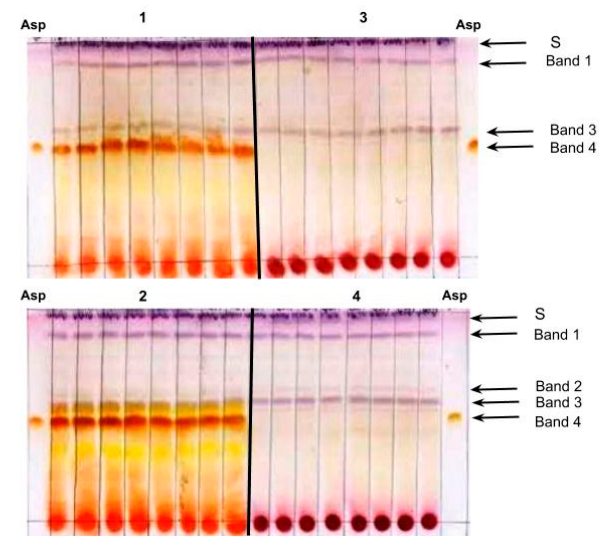
Figure 1. Repeatability test for the TLC method using four rooibos ecotypes with eight repeats. Plants 1 and 2 produce aspalathin, while plants 3 and 4 only produce trace amounts of this compound. Asp: aspalathin standard, S: solvent front.